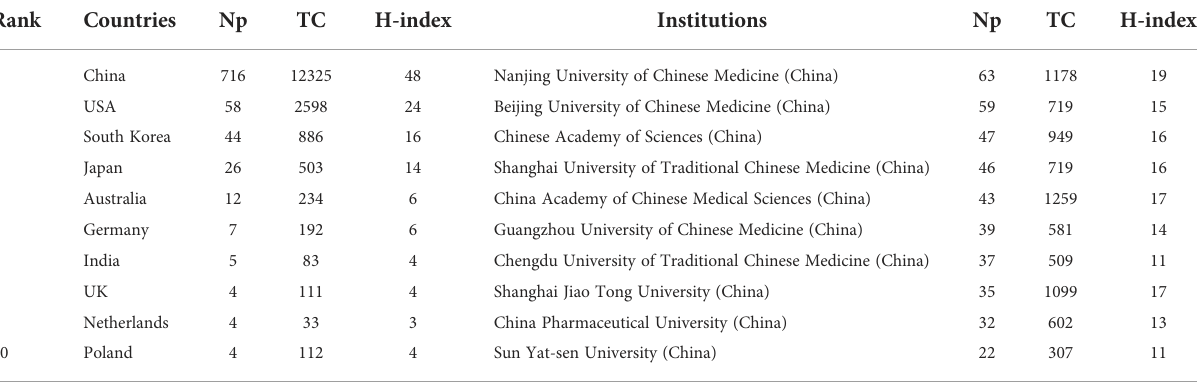
TABLE 3 The top 10 productive countries/regions and institutions involved in the TCM/GM. Rank Countries Np TC H-index